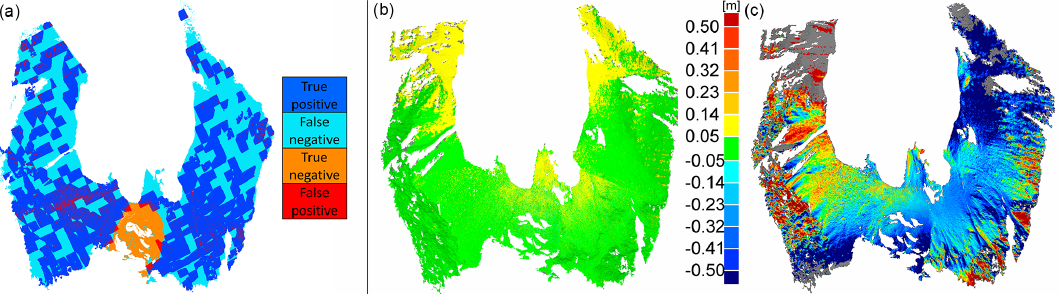
Figure 7. Colour-coded confusion map (a) , change map based on a comparison to the reference data outcome by usage of the ICProx (b) and the ICP (c) at Hinterer Langtalkar rock